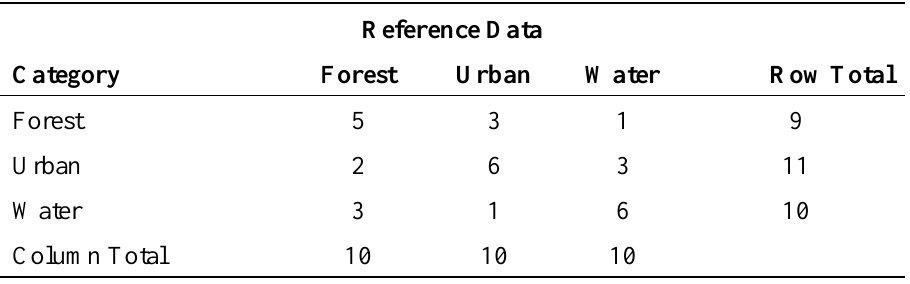
Table 3. Example of error matrix for classification